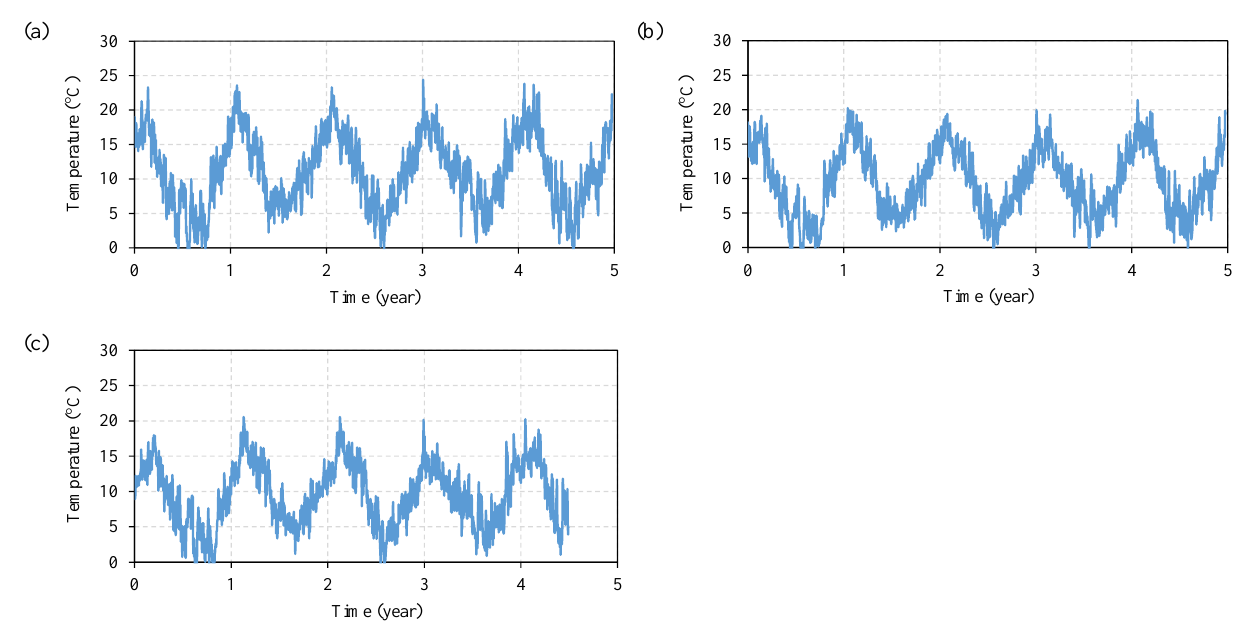
Figure 5. Examples of the mean temperature: ( a ) BRU location ( b ) LT location ( c ) DP location.